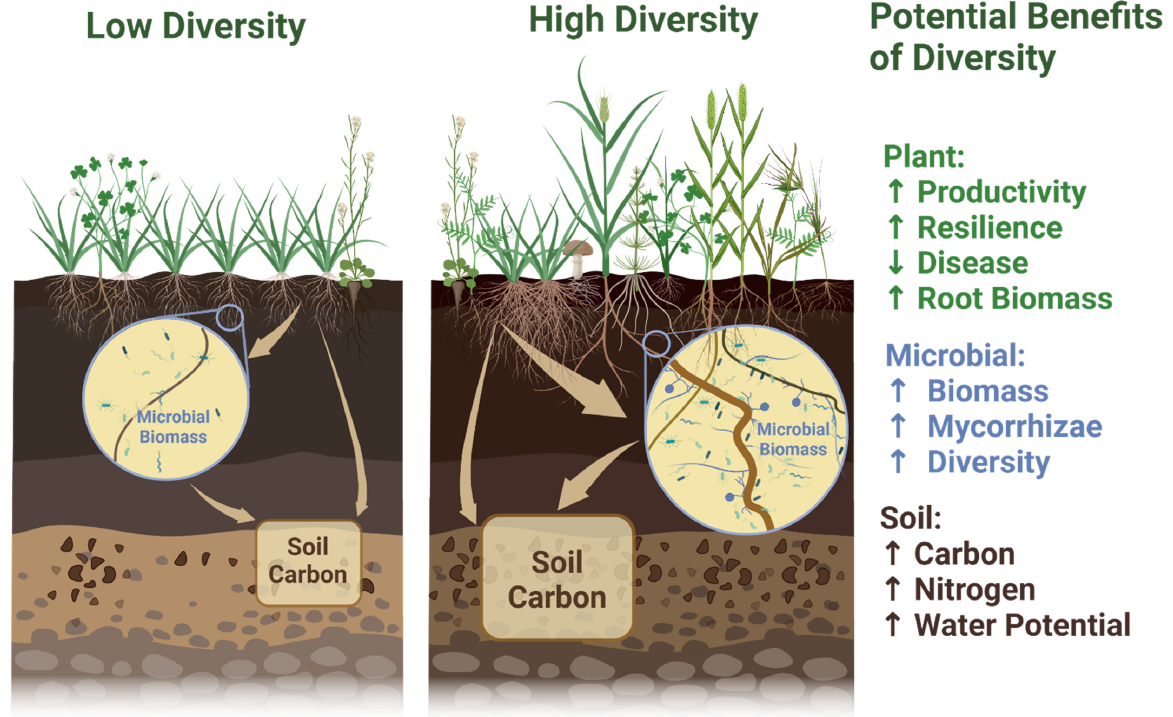
Figure 2. Conceptual model illustrating belowground processes under relatively low- and high-diversity plant communities, along with the potential benefits of increasing diversity [14]. The hypothesized mechanism for elevated soil carbon storage under highly diverse plant communities involves enhanced carbon flow (arrows) in the soil. Specifically, higher root biomass and exudate production in diverse systems supports a more diverse microbial community with greater biomass. As the microbes turnover, this leads to the accumulation of more slow-cycling microbially processed soil carbon under diverse plant communities [80]. Created with BioRender.